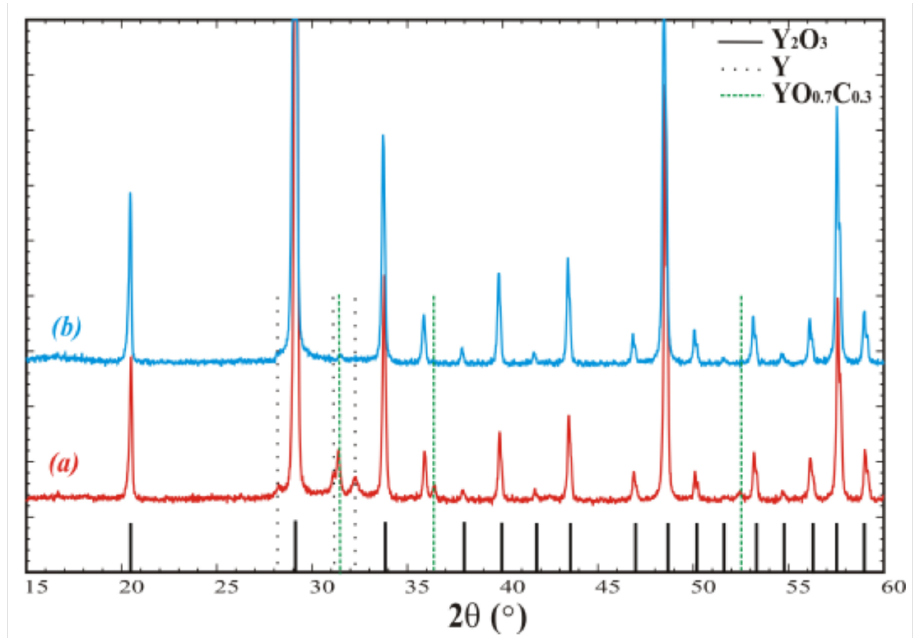
Figure 1. Powder diffraction patterns of crystallized Y 2 O 3 ( a ) in open crucible and ( b ) in crucible covered with lid and additional screening. Peaks corresponding to the admixtures are denoted by the dashed and dotted vertical